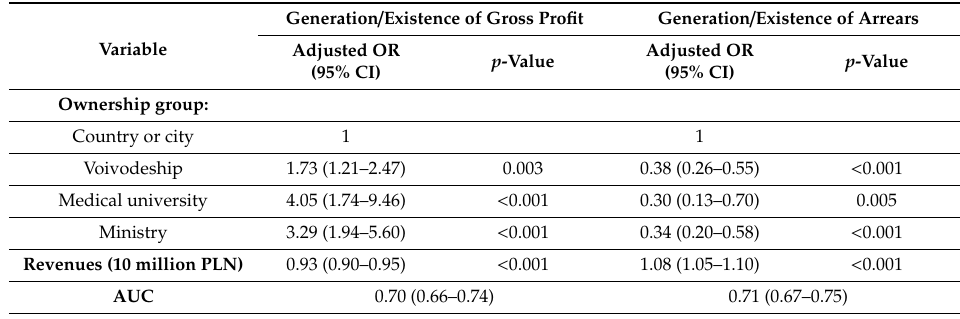
Table 5. Multivariable logistic regression models predicting gross profit and arrears generation (ownership group and revenues as variables).